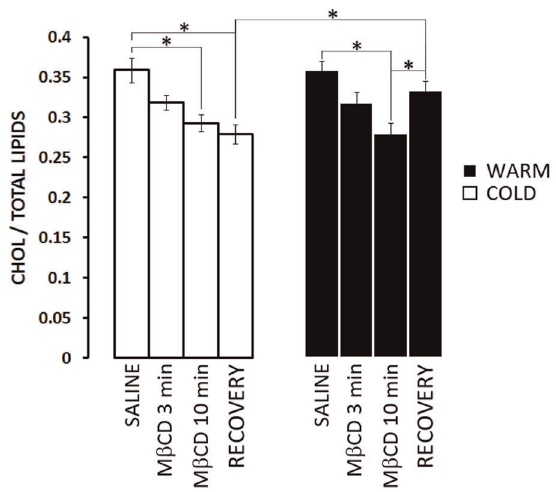
Figure 5. M b CD caused comparable significant cholesterol depletion in warm- and cold-acclimatized groups but this effect was irreversible in the latter. Cholesterol concentrations were assessed in the same neuromuscular preparations used for the electrophysiological analyses (Figures 1–4). Cold-acclimatized groups (open bars). Application of 10 mM M b CD resulted in a significant reduction in cholesterol after 10 min. Attempts to recover cholesterol by perfusion with Ch-HP b CD (RECOVERY) were unsuccessful. Warm- acclimatized groups (solid bars). Application of 10 mM M b CD resulted in a significant reduction in cholesterol after 10 min, comparable to that measured in the cold-acclimatized group. Subsequent perfusion with Ch-HP b CD resulted in recovery to a level comparable to the saline control group (i.e. baseline). N=7. * indicates P , 0.05.